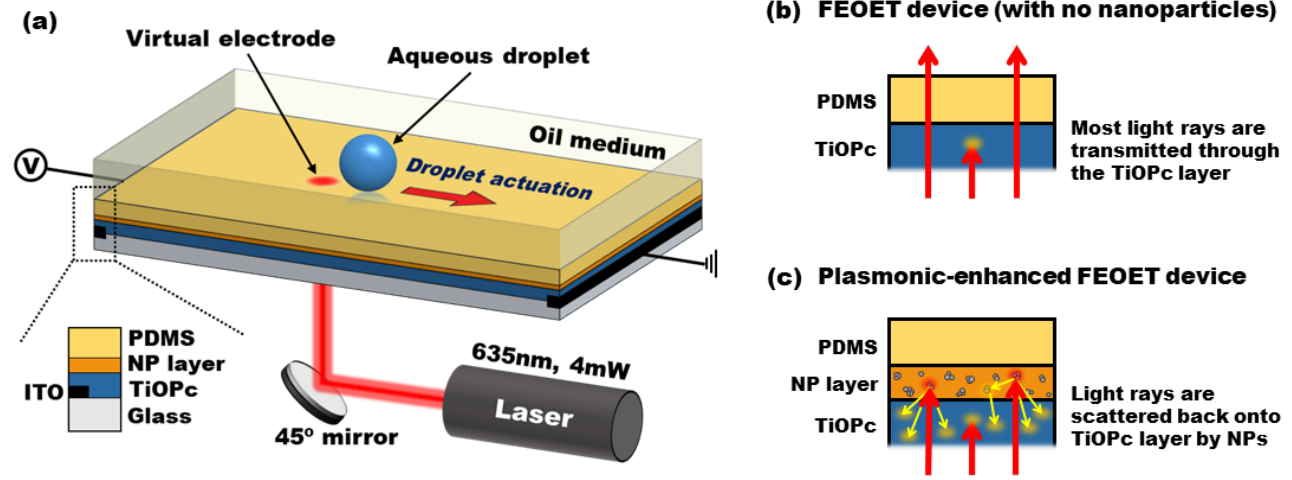
Figure 1. A schematic of the plasmonic-enhanced FEOET device. ( a ) The device consists of an 8- µm TiOPc layer on top of which metallic nanoparticles are dispersed. The thickness of a nanoparticle (NP) layer is varied to understand the thickness effect on plasmonic-enhanced DEP performance of the device. An open PDMS chamber with its thickness of 12.5 µm is finally placed above the NP layer to house droplets surrounded by an oil medium. ( b ) For the FEOET device without the nanoparticle layer, only a small portion of the input optical rays can be absorbed on the TiOPc layer due to its poor photoconductive property. Most of the rays just pass through it before making a contribution to its photo-state conductivity, resulting in poor DEP performance. ( c ) However, by using plasmonic nanoparticles as light scattering elements above the TiOPc layer, the transmitted rays experience light scattering and effectively increase their optical path lengths over a wide angular spread. Then, more light rays are redirected and absorbed within the TiOPc layer, thus significantly enhancing the photoconductivity. As a consequence, the DEP performance of the FEOET device can be greatly improved for effective optical droplet